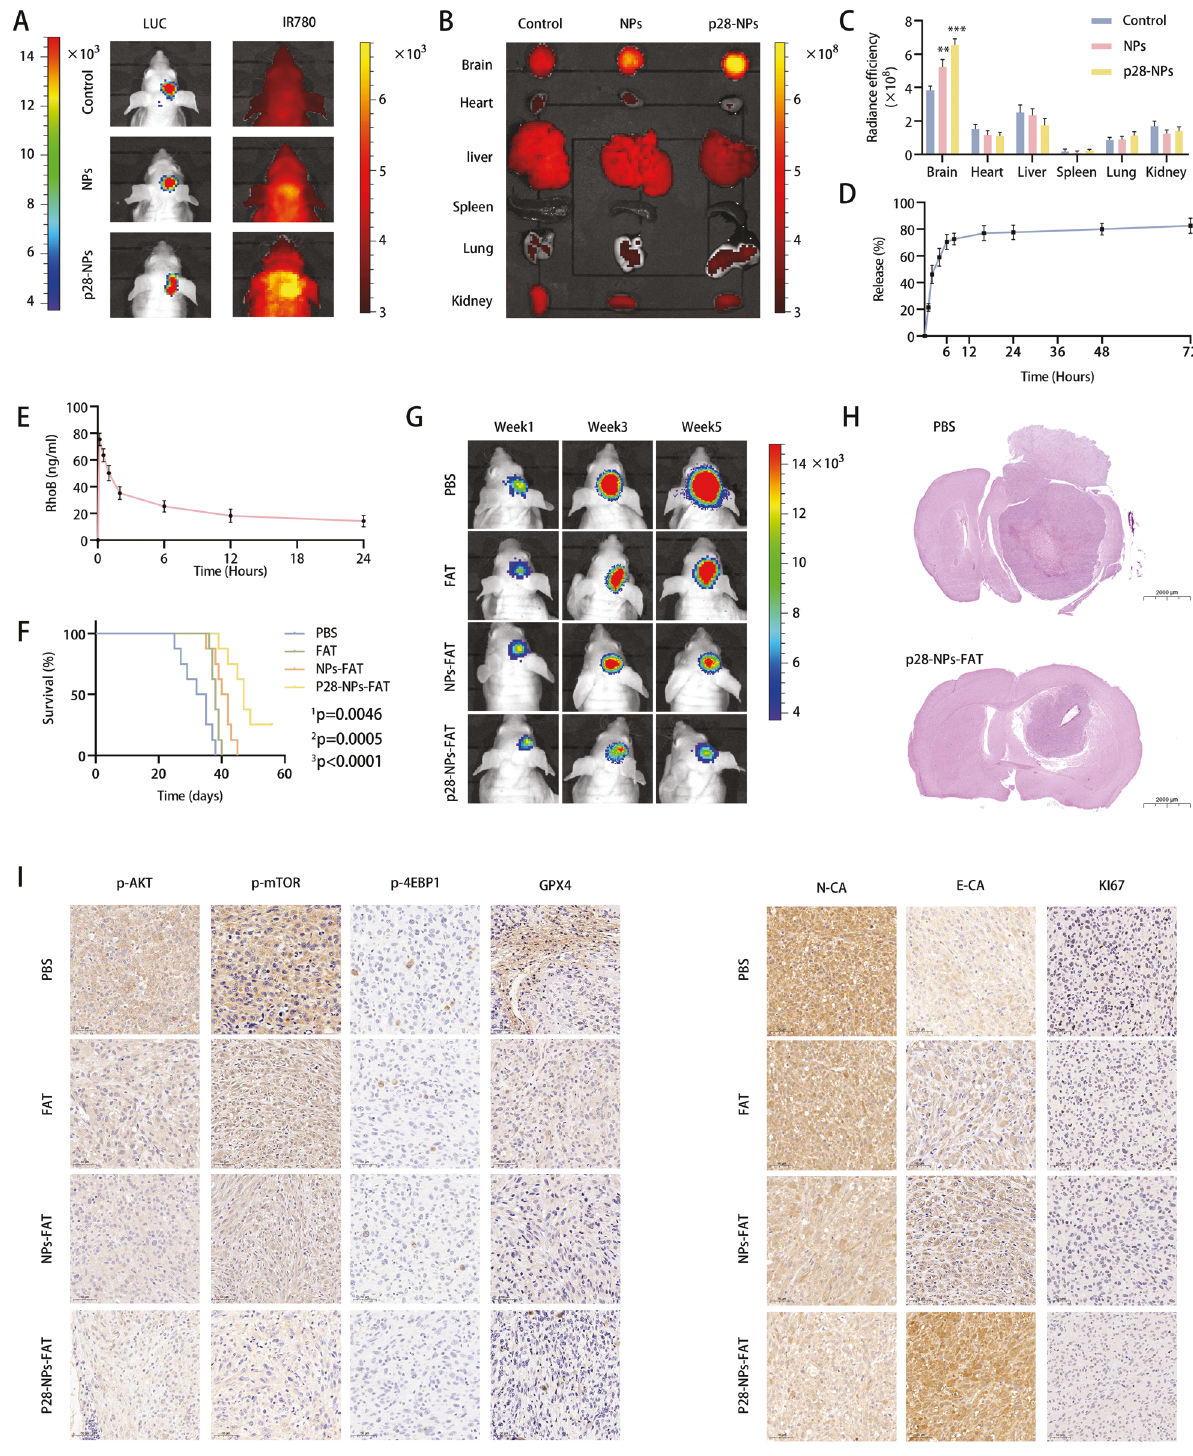
Fig. 8 Fatostatin NPs target GBM and inhibit GBM growth in an intracranial xenograft model. A Representative IVIS imaging of the tumor- bearing mice treated with free IR780 (control), NPs loaded with IR780, and p28-NPs loaded with IR780, respectively. The left image is luciferase fl uorescence indicating the tumor size, and the right image is the IR780 signal indicating the accumulation of IR780 particles. B IVIS imaging of the isolated organs showed the IR780 signal in the brain, heart, liver, spleen, lung, and kidney of mice receiving the corresponding treatments. C The semiquanti fi cation of the NPs-IR780 signal from the isolated organs. D The controlled release of p28-NPs-FAT in PBS. E The plasma concentration of RhoB was detected at predetermined time intervals after intravenous injection of p28-NPs loaded with RhoB. F Kaplan ‒ Meier curves showing the survival of the untreated or treated mice in the experimental groups. ( 1 p: comparing the PBS with fatostatin (FAT) treatment group; 2 p: comparing the PBS with NPs-FAT treatment group; 3 p: comparing the PBS with p28-NPs-FAT treatment group.) G Representative bioluminescence images from IVIS imaging showed the tumor luciferase signal in the mice of different treatment groups at 1, 3, and 5 weeks. H Representative images of H&E staining of brain sections of the different groups. I Representative IHC images showing the expression levels of p-AKT, p-mTOR, p-4EBP1, GPX4, E-ca, and N-ca in brain